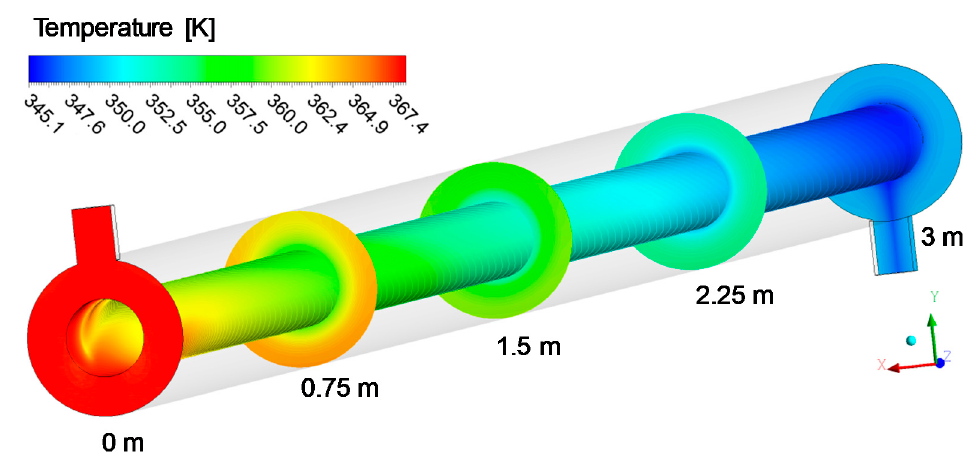
Figure 12. Temperature field inside the shell and tube module for T 0 = 95 °C (Case 8).